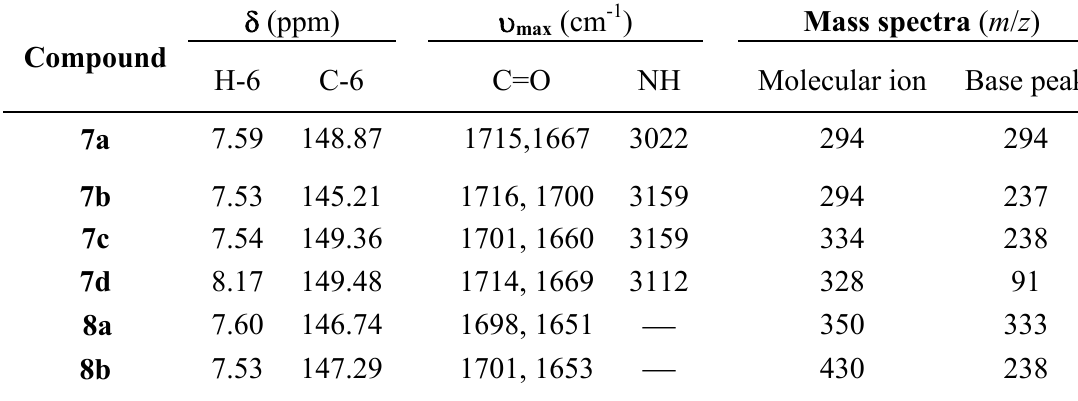
Table 2. Selected spectral data of N1- and N1,N3-substituted uracils 7 and 8